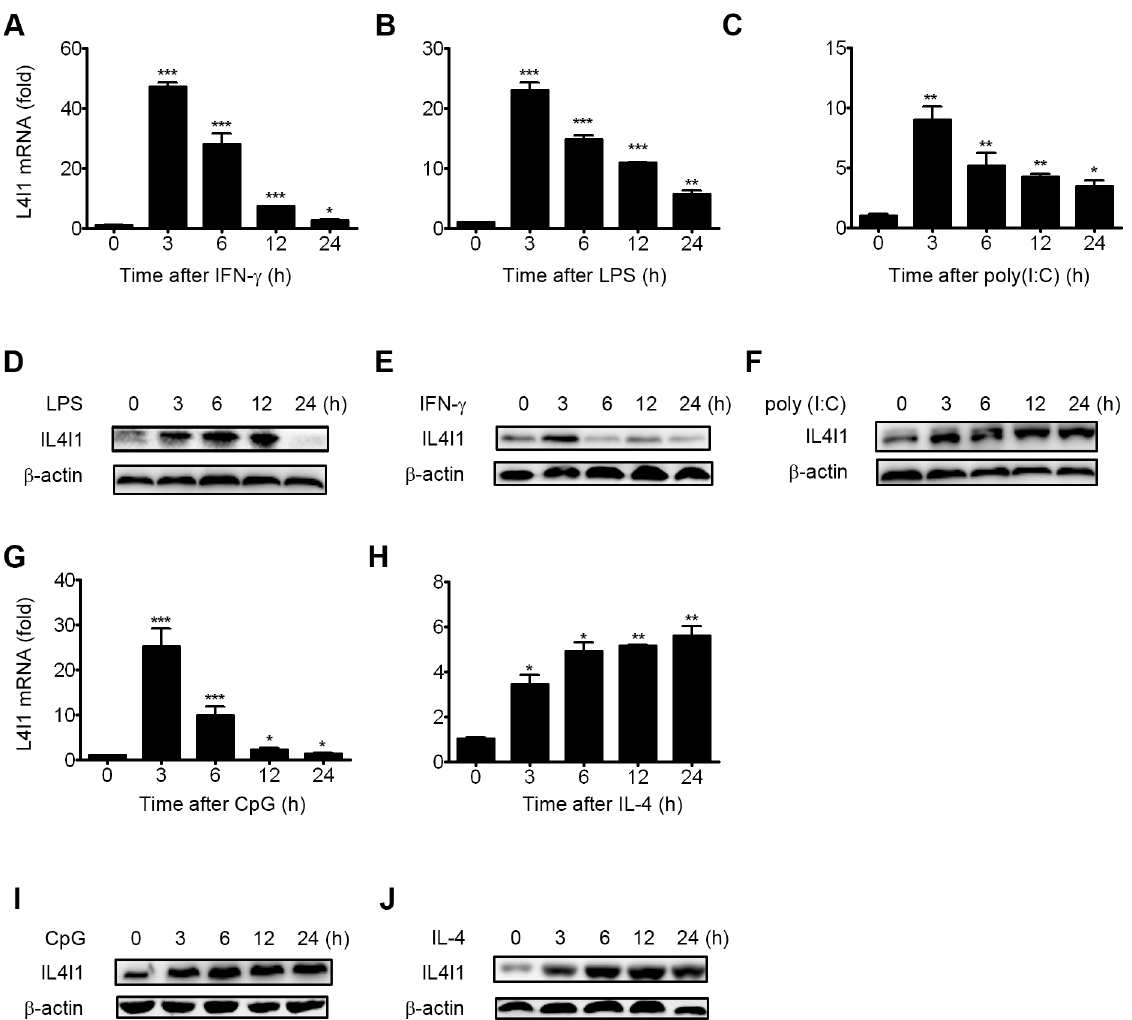
Fig 2. Induction of IL4I1 expression in macrophages. BMDMs were treated with LPS (100 ng/mL), IFN- γ (15 ng/mL), poly(I:C) (1 μ g/mL), CpG (0.3 μ M), or IL-4 (10 ng/mL) for the indicated amounts of time or were left untreated. Levels of IL4I1 expression were assayed by q-PCR (A – C, G – H) and western blotting (D – F, I – J), respectively. β -actin was used as a loading control throughout. Representative data are presented as means ± S.D. of three or four independent experiments. Significance was calculated by two tailed unpaired Student's t -test. Asterisks indicate significant differences compared to untreated